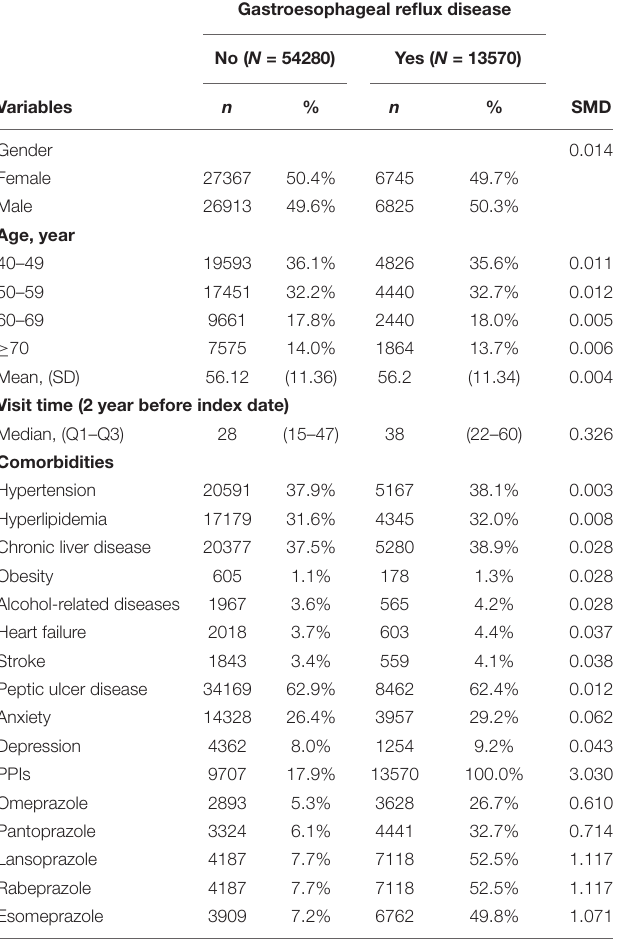
TABLE 1 | Baseline characteristics between non-GERD and GERD cohort.